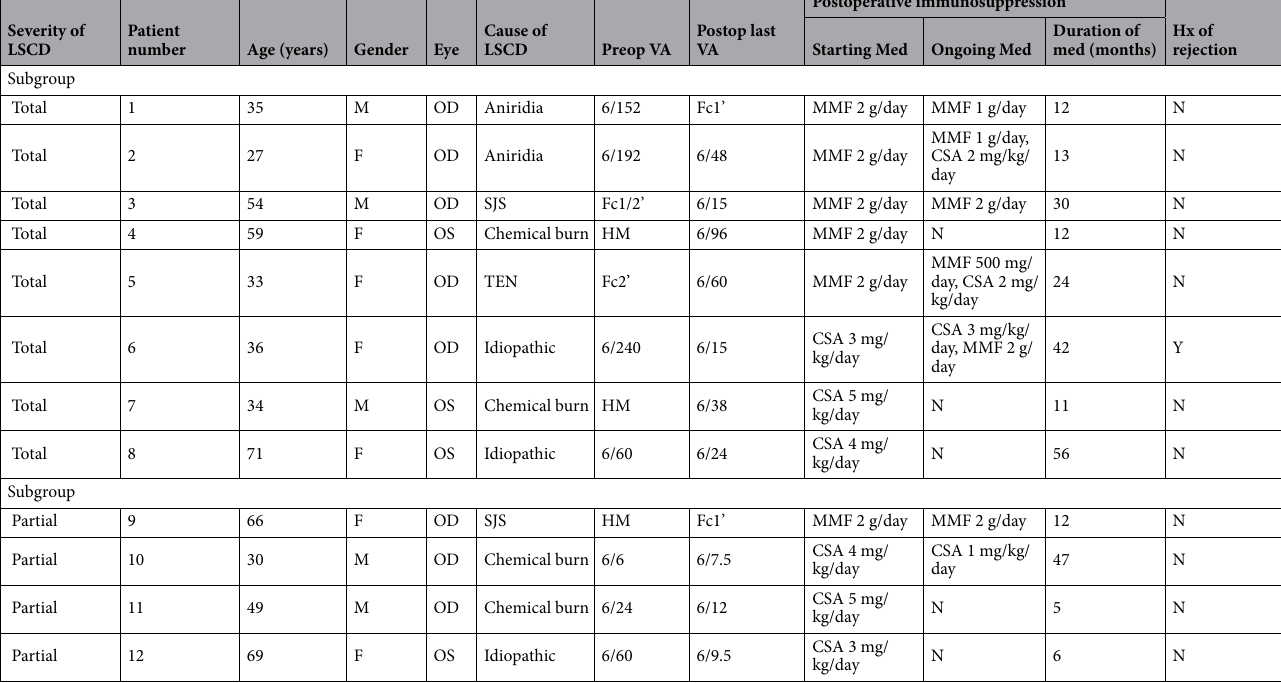
Table 1. Demographic data and clinical patient characteristics at the time of genotypic analysis. Preop VA, preoperative visual acuity; Postop last VA, postoperative last visual acuity; Starting med, starting medication at the perioperative time; Ongoing med, ongoing medications at the time of genotypic analysis; Duration of med, total duration of medications before the genotypic analysis; Hx of rejection, history of graft rejection before the genotypic analysis; M, male; F, female; OD, right eye; OS, left eye; SJS, Stevens-Johnson syndrome; TEN, toxic epidermal necrolysis; Fc, counting finger; HM, hand motion; CSA, cyclosporine A; MMF, mycophenolate mofetil; Y, yes; N,